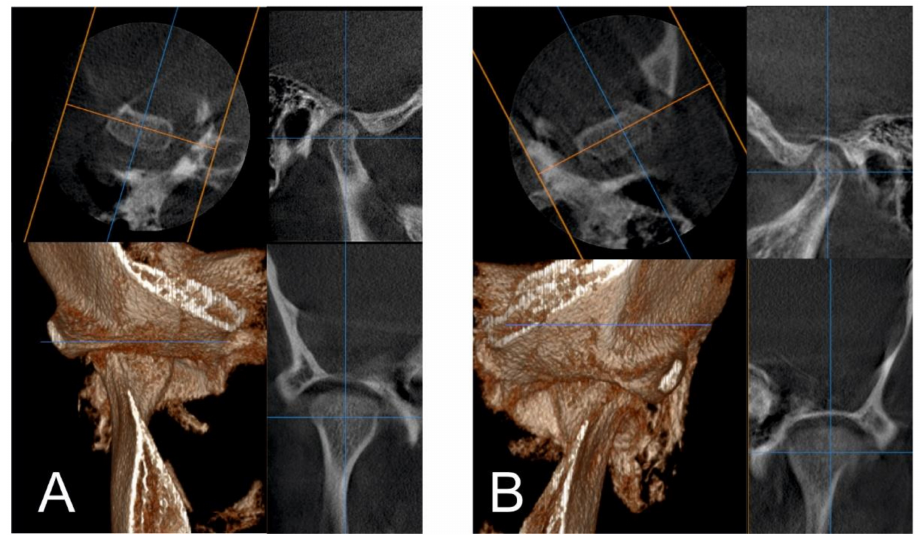
Figure 8. Pre-treatment TMJ aspect on CBCT: right ( A ) and left ( B ) TMJ with coronal, sagittal, axial cross-sections and 3d